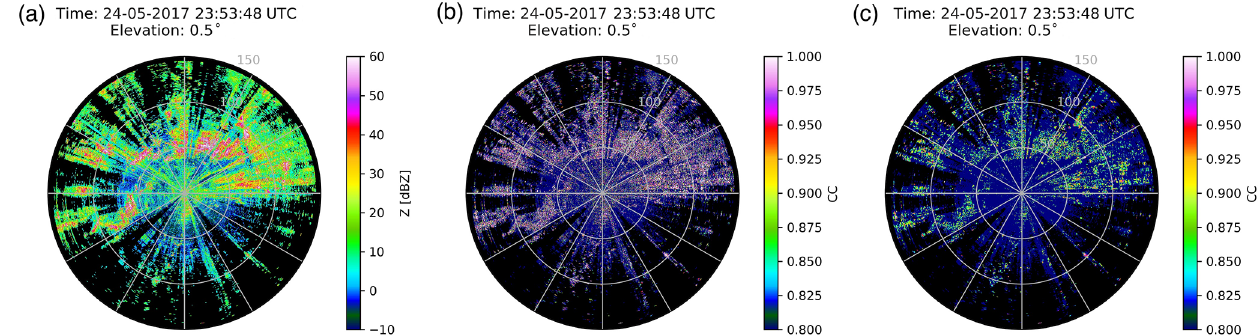
Figure 6. (a) Z , (b) CC, and (c) CC after averaging along the radial using a 1.5km window. All from NUIST-CDP at 23:53UTC on 24 May 2017 from an elevation of 0.5 ◦